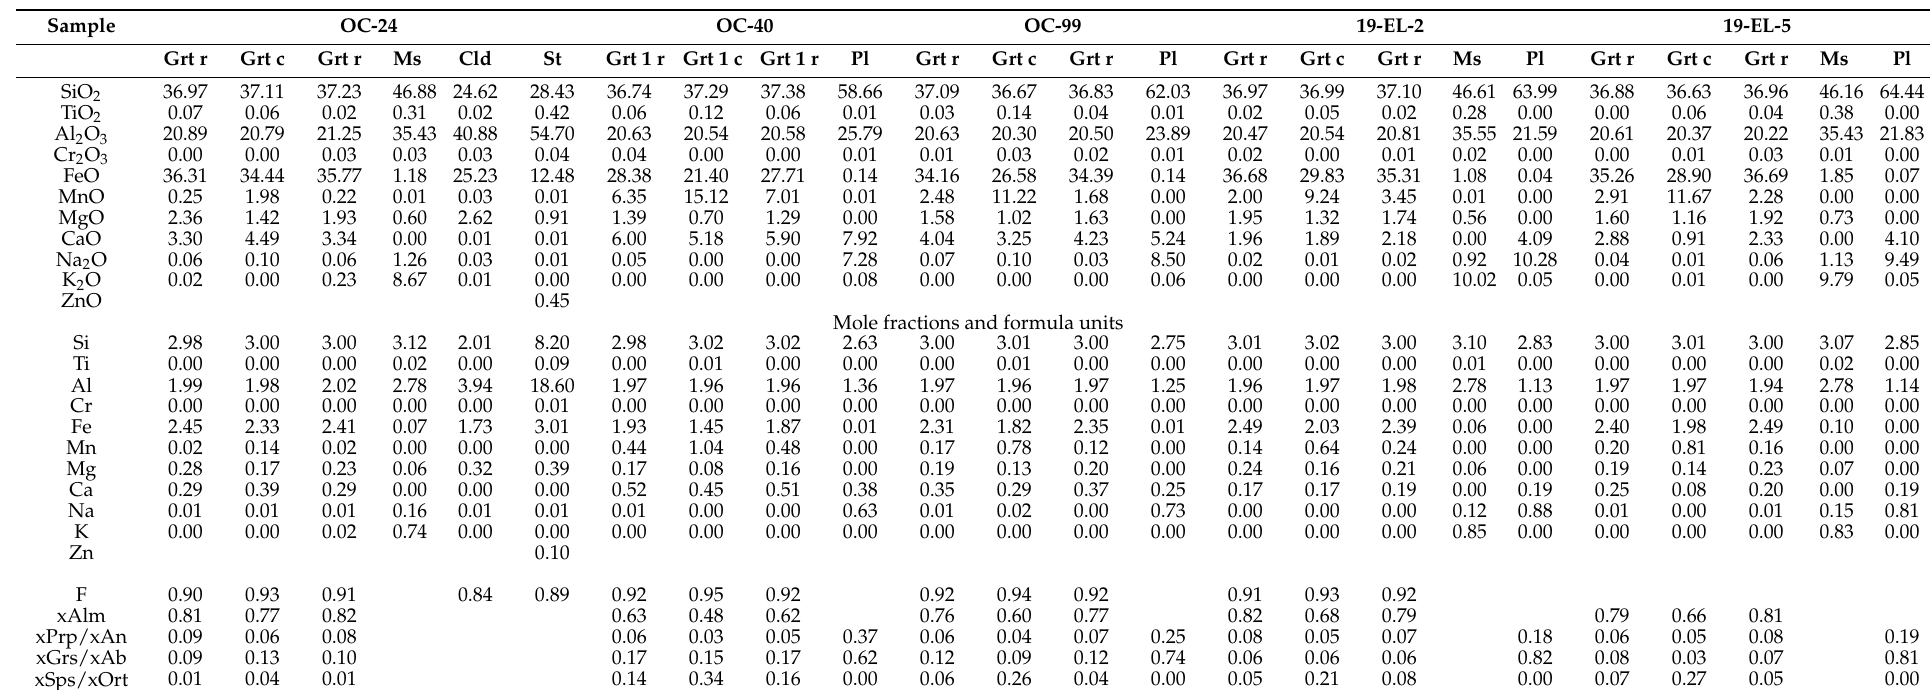
Table 1. Garnet, muscovite, plagioclase, chloritoid and staurolite composition.